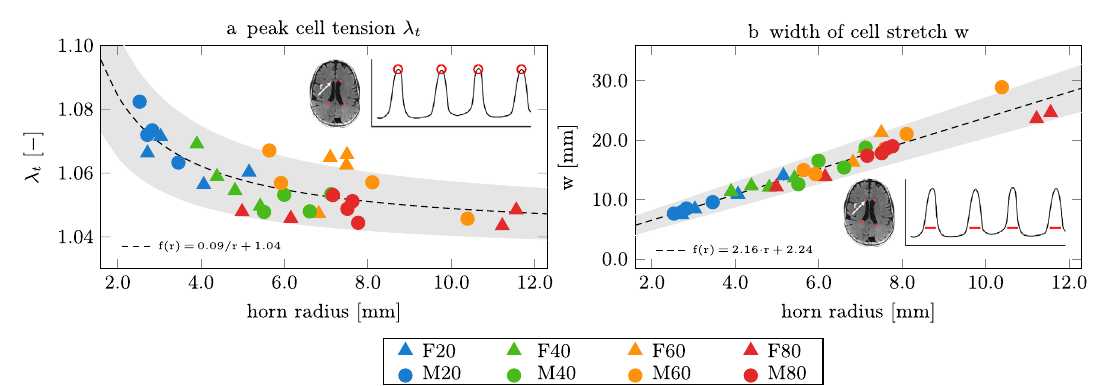
Figure 6. Ventricular geometry is an indicator for peak cell stretch (a) and the wall fraction exposed to elevated cell stretch (b). We measure the radius of a sphere fitted to the anterior and posterior horns as a representative marker for ventricular geometry. We observe that peak cell stretch decreases for increasing horn radii and that an increasing wall section experiences elevated cell stretch as horn radius increases. Our observations suggest that younger brains with sharper ventricular horns, i.e., smaller horn radii, experience higher ependymal cell loading while aged brains (with larger horn radii) experience lower cell loads but elevated stretches on larger wall sections, i.e., increased width of cell